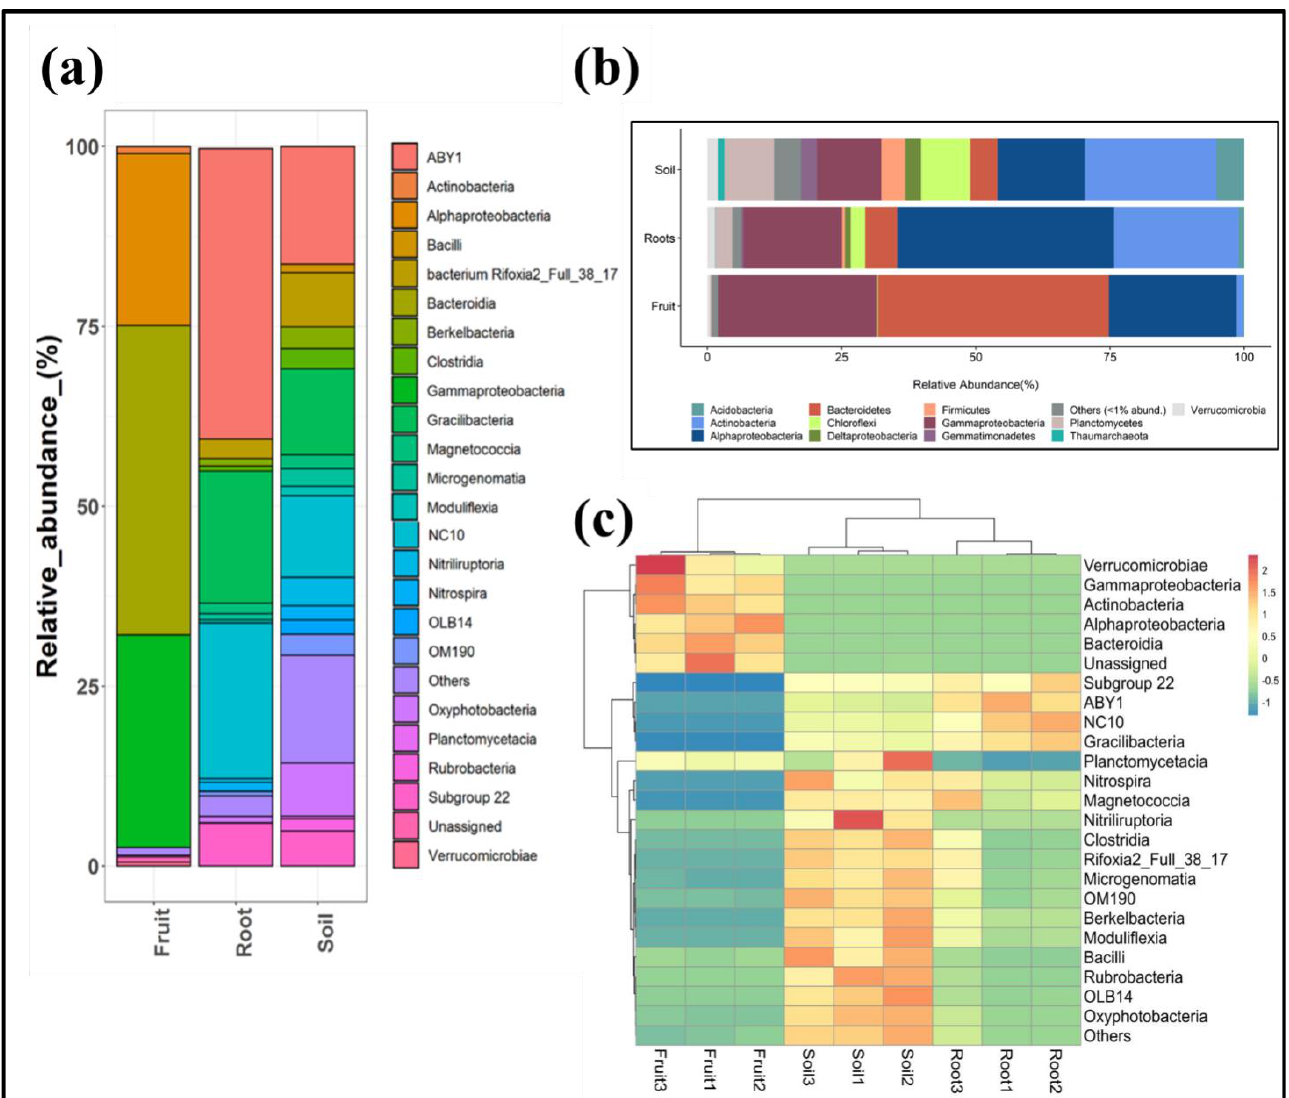
Figure 3. Relative abundance of dominant bacterial groups at the phylum level ( a ); Relative abun- dance of dominant bacterial groups at class level ( b ); Clustering pattern of the bacterial community (at class level) associated with fruit, root, and rhizosphere samples ( c ).